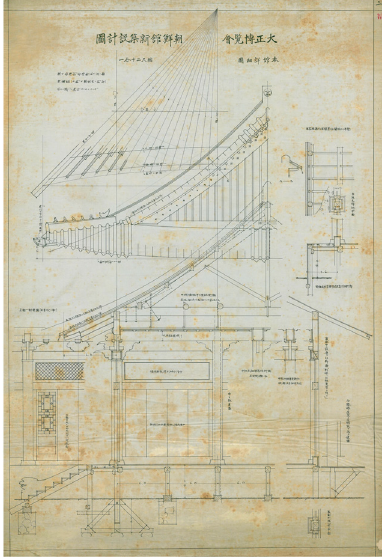
Figure 1. Original Section Drawings of the Korea Pavilion at the 1914 Tokyo Taisho Expo (Source: National Archives of Korea) [5].